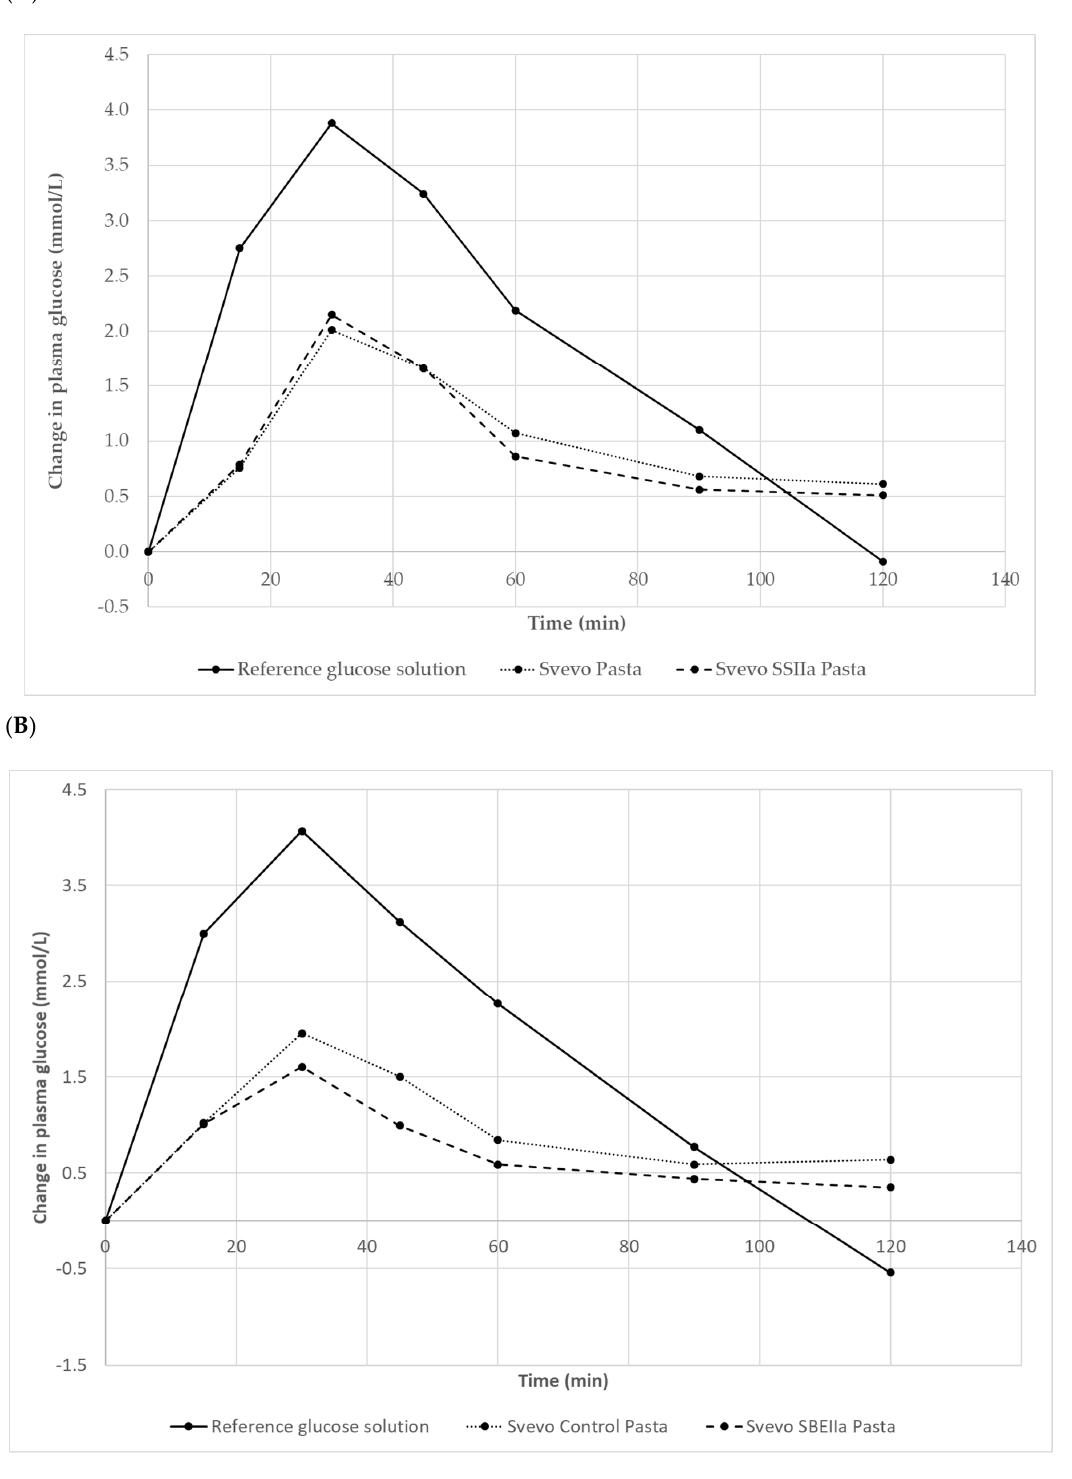
Figure 4. The average plasma glucose response curves (n = 10 subjects) for the equal-carbohydrate portions of the reference food and the two pasta products. ( A ): Svevo 2016 and Svevo SSIIa; ( B ): Svevo 2016 and Svevo SBEIIa, shown as the change in plasma glucose from the fasting baseline level.